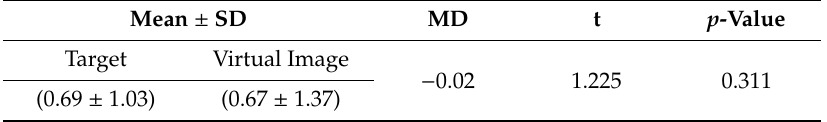
Table 3. Comparison of controlled reaction amount between 0.67 D and virtual